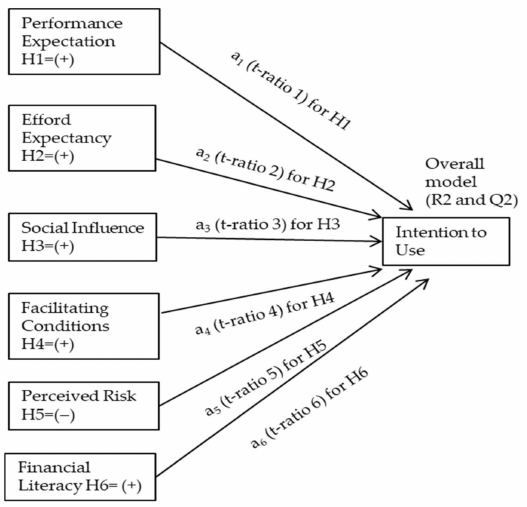
Figure 3. Hypothesis tested and analytical methodology with PLS in [7]. Source: Arias-Oliva, M.; Pelegr í n-Borondo, J.; Mat í as-Clavero, G. Variables influencing cryptocurrency use: a technology acceptance model in Spain. Frontiers in Psychology 2019 , 10, 475.